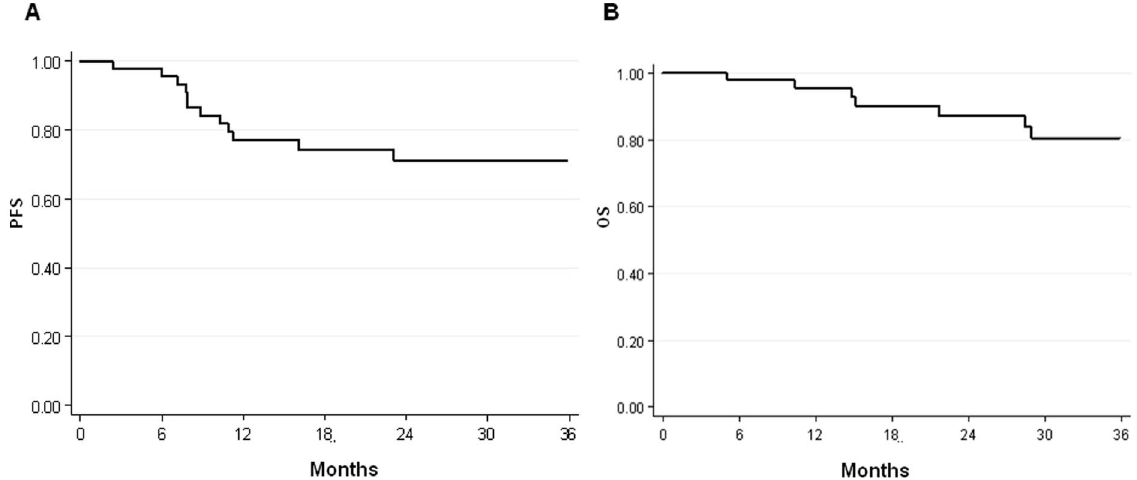
Figure 1. Kaplan-Meier survival curves of (A) progression-free survival (PFS) and (B) overall survival (OS). doi:10.1371/journal.pone.0092071.g001 PLOS ONE |